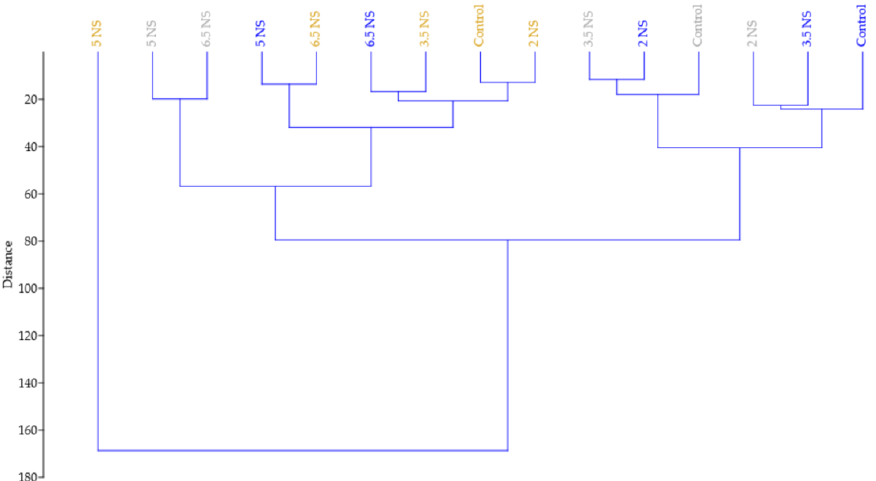
Figure 5. Hierarchical clustering of the Viola × wittrockiana seedlings based on the growth and number of inflorescences. Colored designation represents the type of seedlings (grey—White Viola seedlings; blue—Blue Viola seedlings; golden—Yellow Viola seedlings).